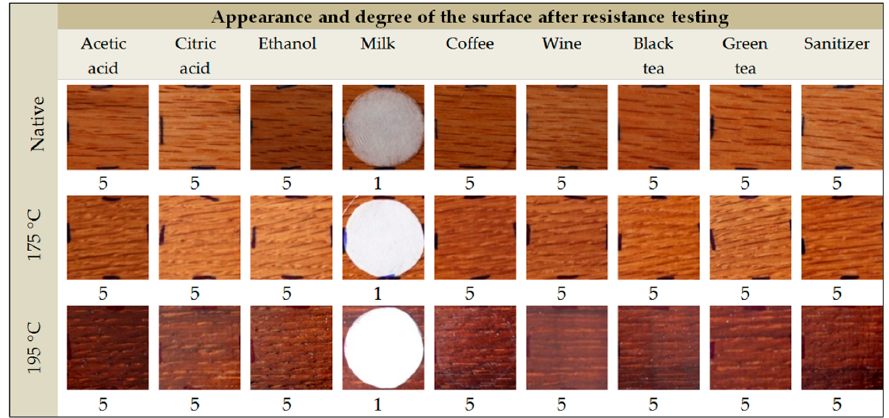
Figure 8. Resistance to cold liquids (degree): surface finish of linseed oil + oil.